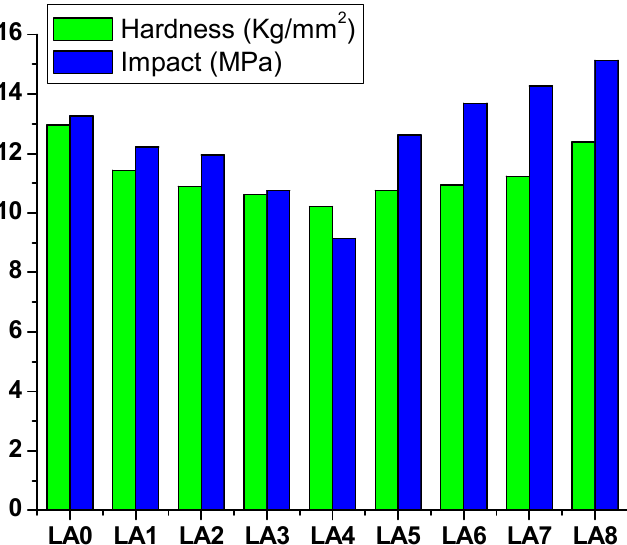
Figure 9. Hardness and impact strength of GLS@PET versus LANPs concentration.